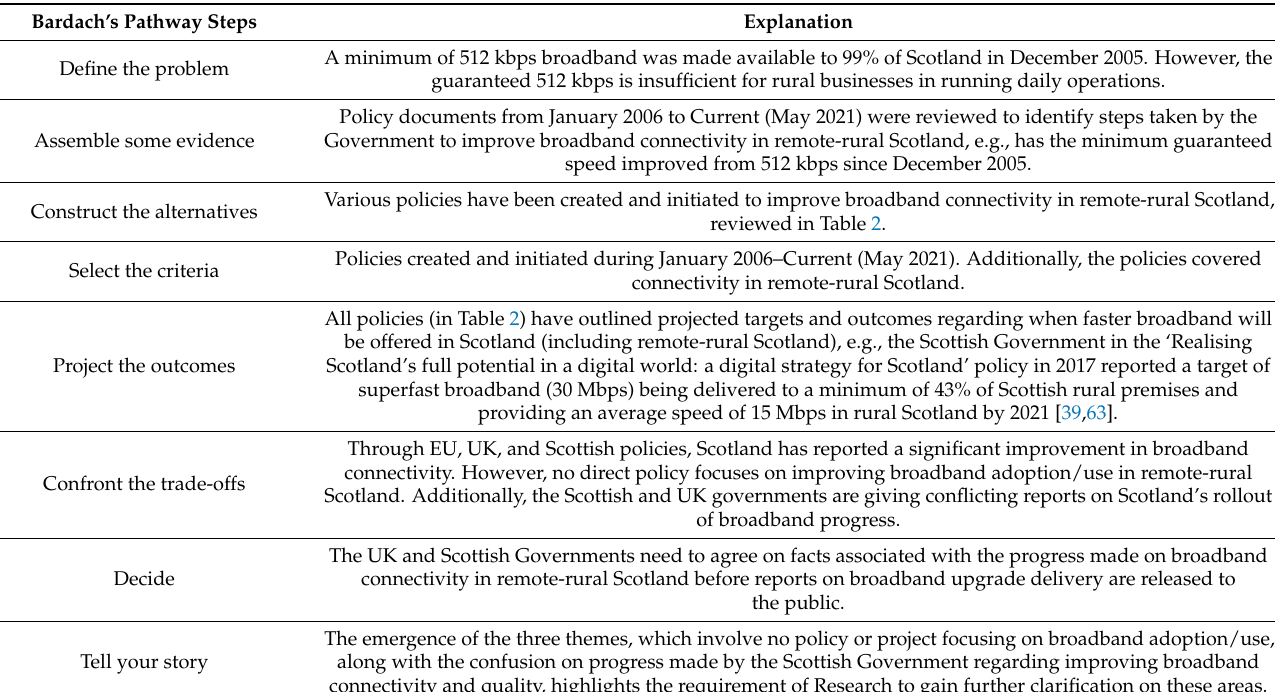
Table 4. Policy Analysis of EU/UK/Scottish Government documents on broadband (January 2006–May